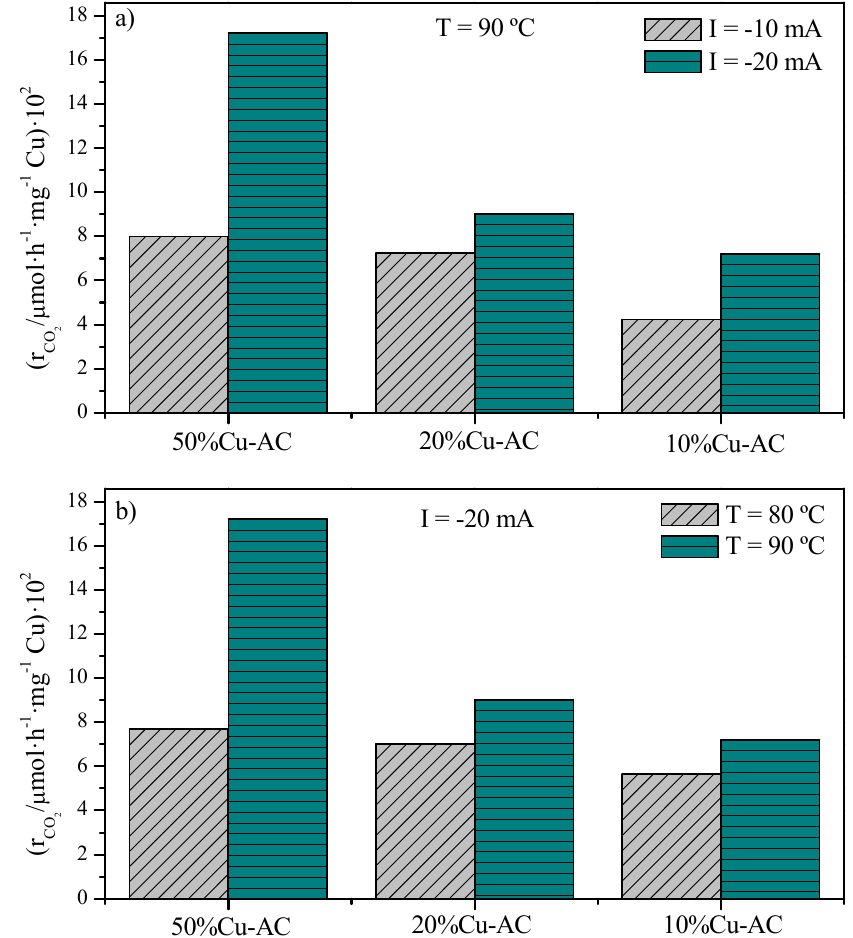
Figure 4. ( a ) Effect of the current at 90 °C and ( b ) temperature at I = −20 mA on the steady state CO 2 consumption rate for the cathodic-catalysts 50% Cu-AC, 20% Cu-AC, and 10% Cu-AC. Conditions: F _(CO_2) , cathode = 1.65 NmL·min −1 y F_( H_2O ), anode = 6 NmL·min −1 .